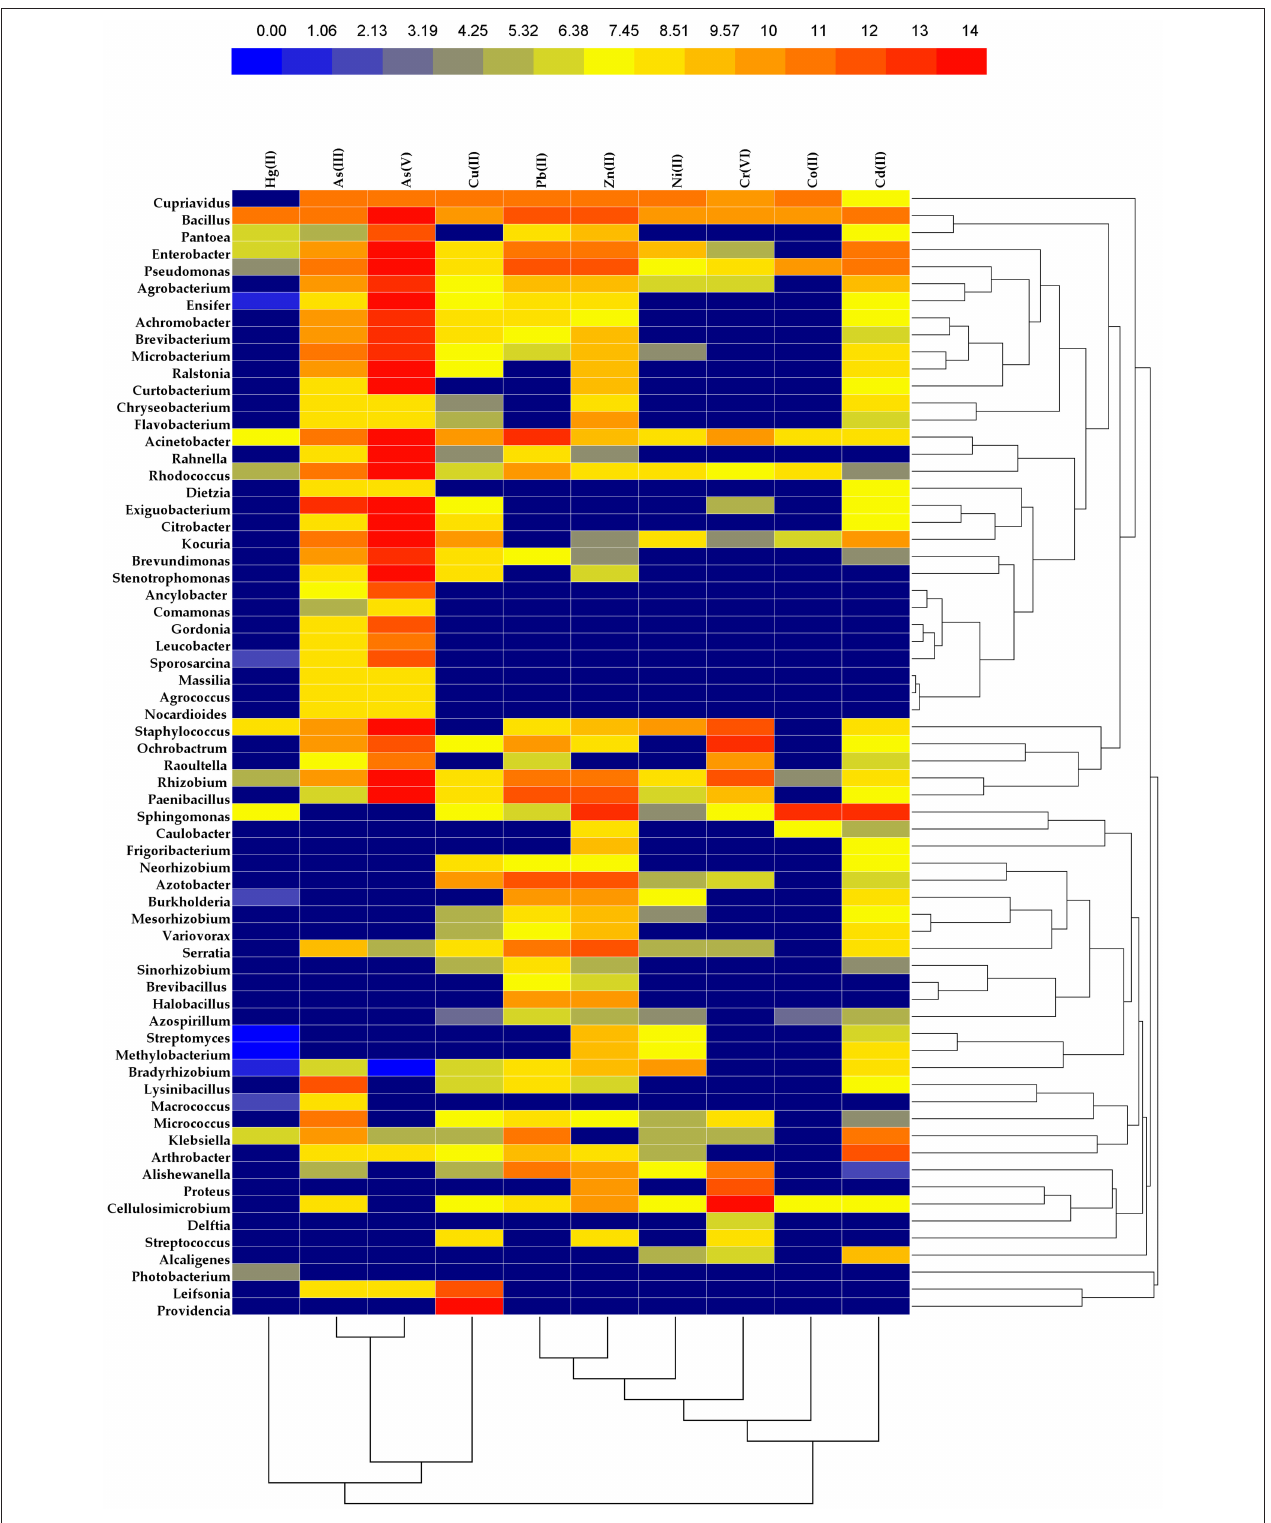
FIGURE 3 | Heat map comparing the different levels of heavy metal resistant efficiency in several majorly studied bacterial genera having plant-growth-promotion attributes. Two-dimensional clustering is also shown involving the 10 major heavy metals on one hand and 67 representative bacterial genera on the other. Concentration of heavy metals are calculated and expressed using mg/L